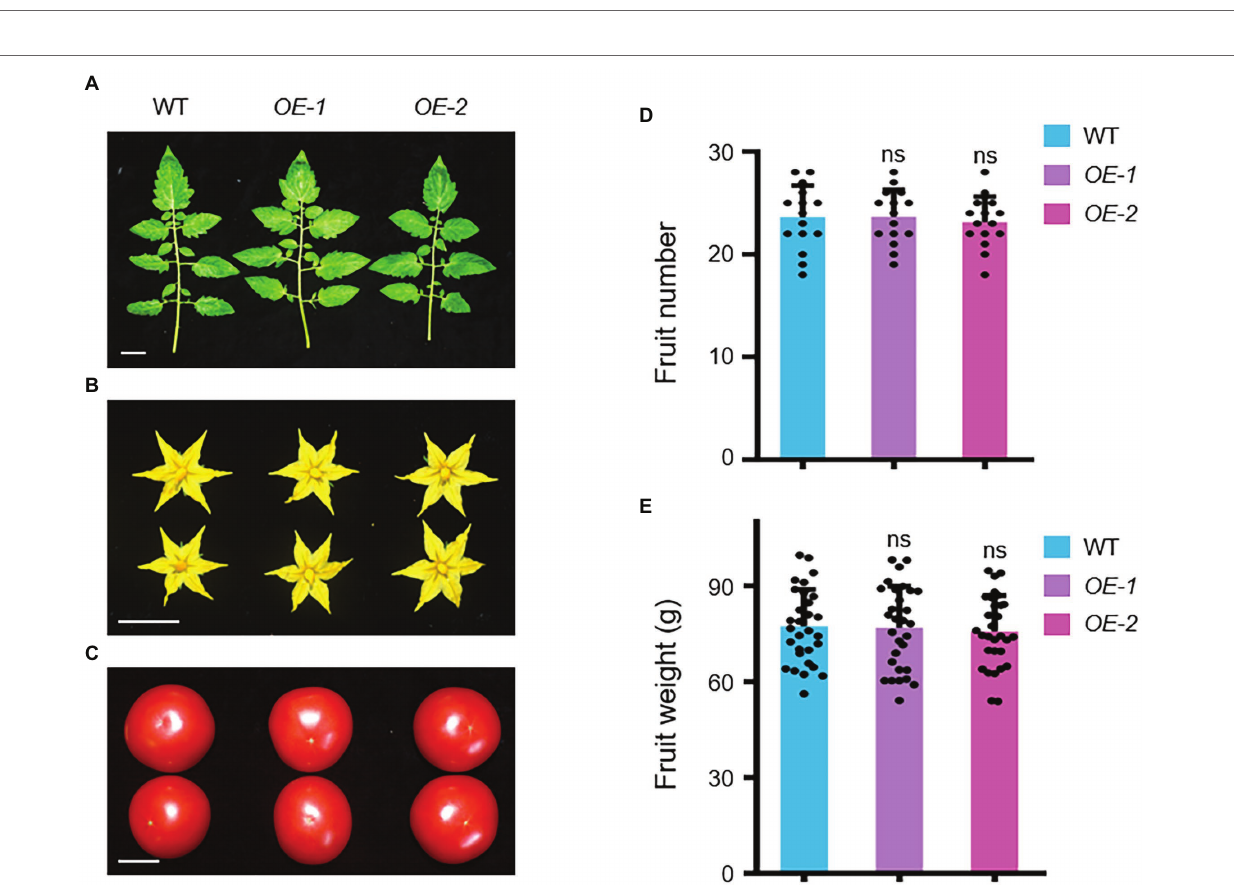
FIGURE 5 | Agronomic Traits of SlLecRK1 - OE Plants. The leaves (A) , flowers (B) , and fruits (C) were observed in two OE plants compared with the WT control at the harvest stage. Bars, 3 cm. (D) The statistical data for fruit number ( n = 10 plants). (E) The statistical data for fruit weight ( n = 30 from 10 plants). Different letters denote significant differences by Student’s t- test (ns, not